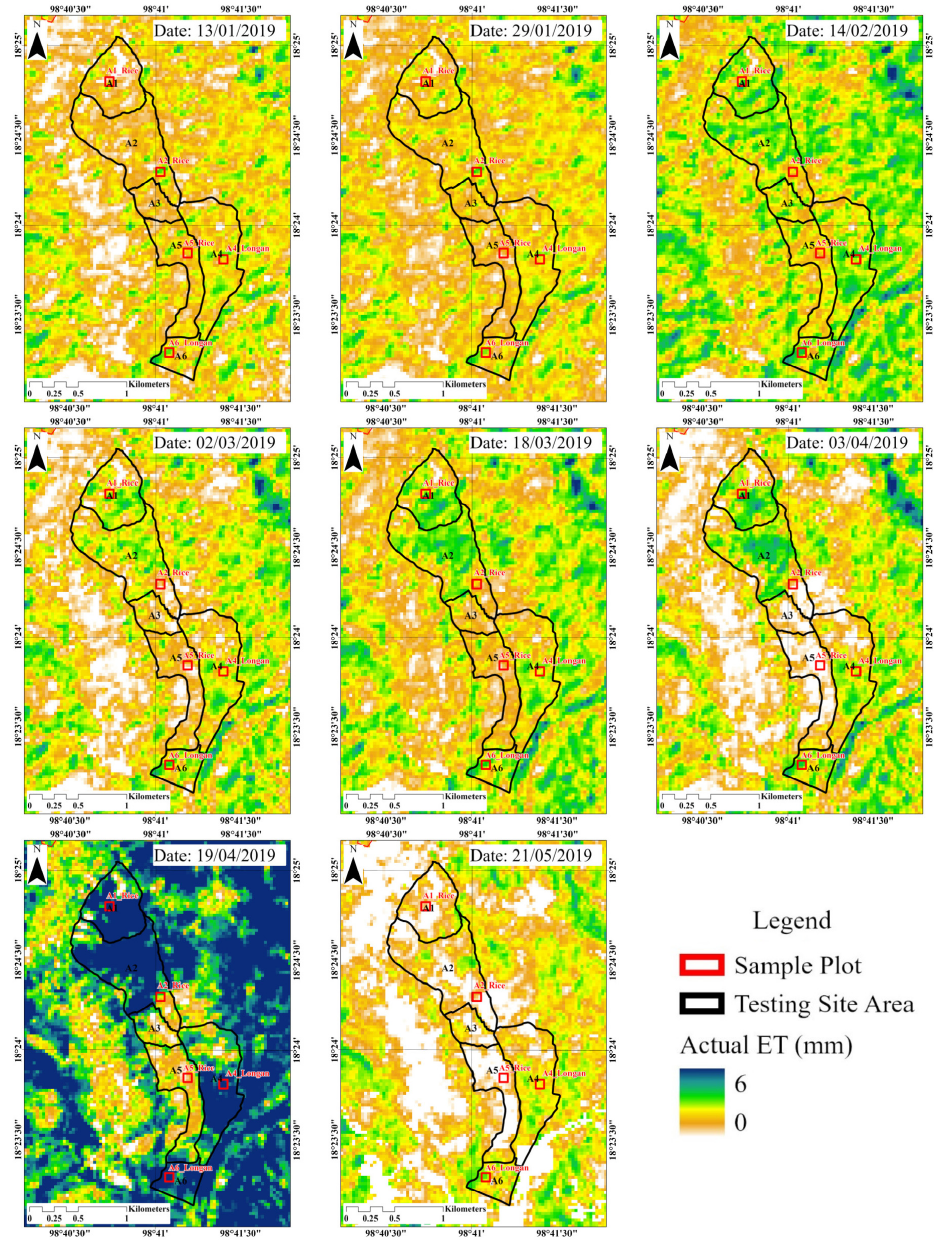
Figure 4. Daily actual evapotranspiration ( ET a ) estimates for the testing area in the Chom Thong District, Chiang Mai Province, downstream of the Muang Luang Weir, Thailand, based on the mapping evapotranspiration at high resolution with internalized calibration (METRIC) model.